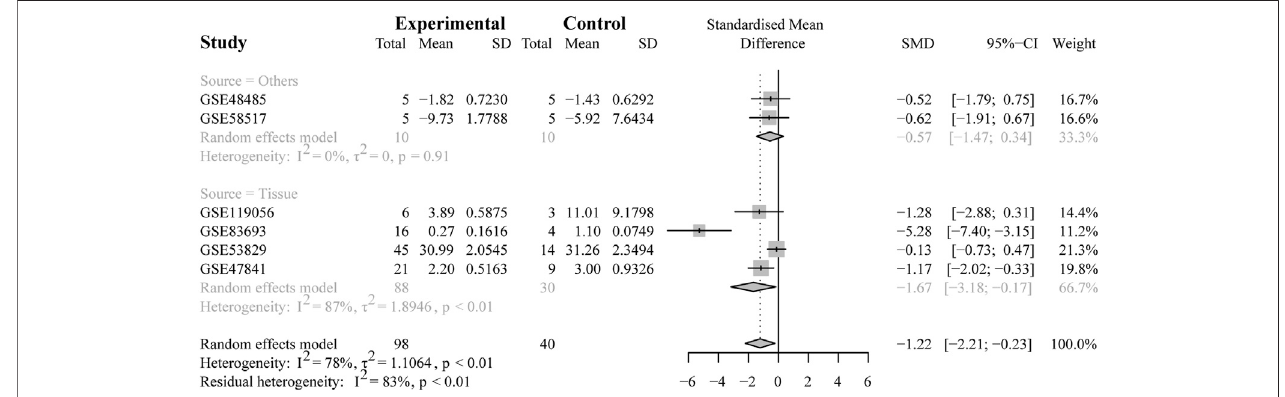
FIGURE4| Resultsofthesubgroupanalysis.Thesubgroup analysisbasedonsamplesources(non-tissueortissue).Theresultindicatedthatthetissuesubgroup had obvious heterogeneity (I 2 (cid:2) 87%, p < 0.01).